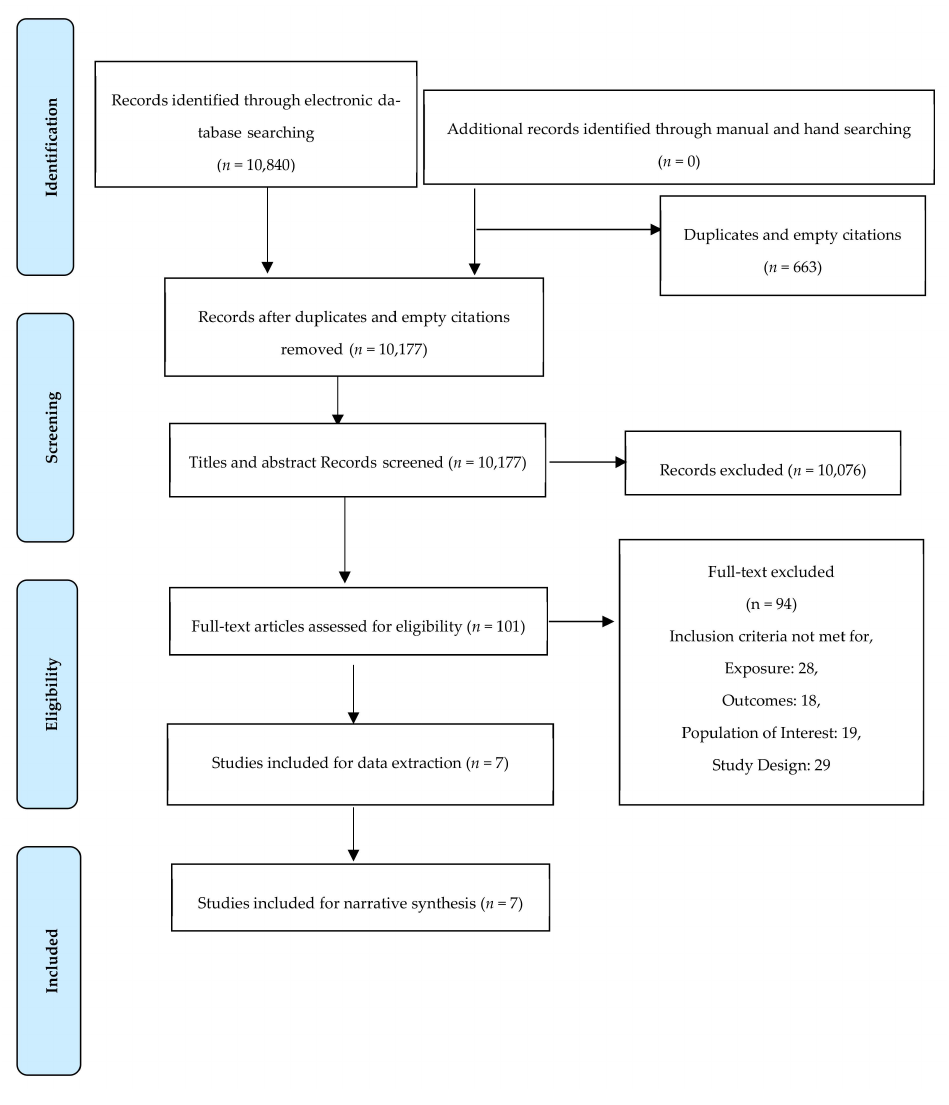
Figure 1. The PRISMA flow chart illustrating search and screening